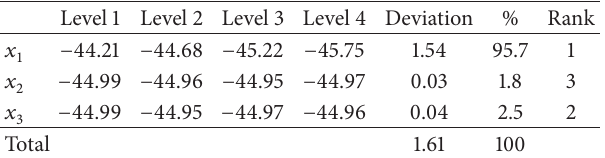
Table 4: Analysis results on the effect of the design variables on the pressure drop.